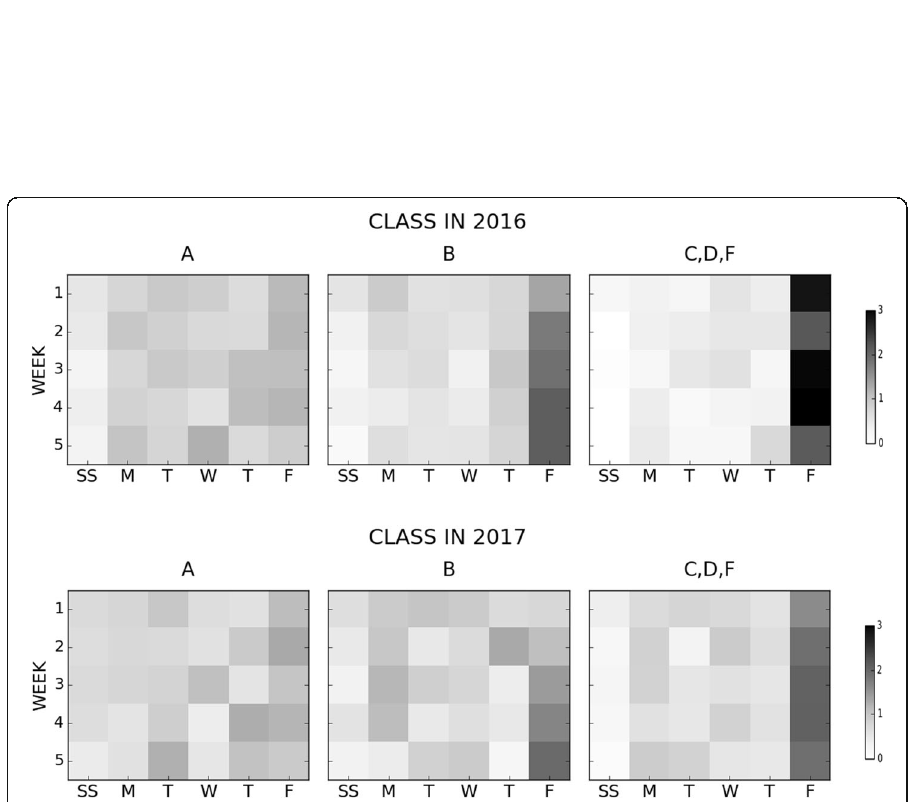
Fig. 7 The number of task counts per day, for each of the 5 weeks, averaged over the students in each grade group. The number of students in each grade group was 84 (A), 66 (B), and 22 (C, D, F) in class 2016, and 27 (A), 37 (B), and 76 (C,D,F) in class 2017. Figure based on data and analyses in Park et al.